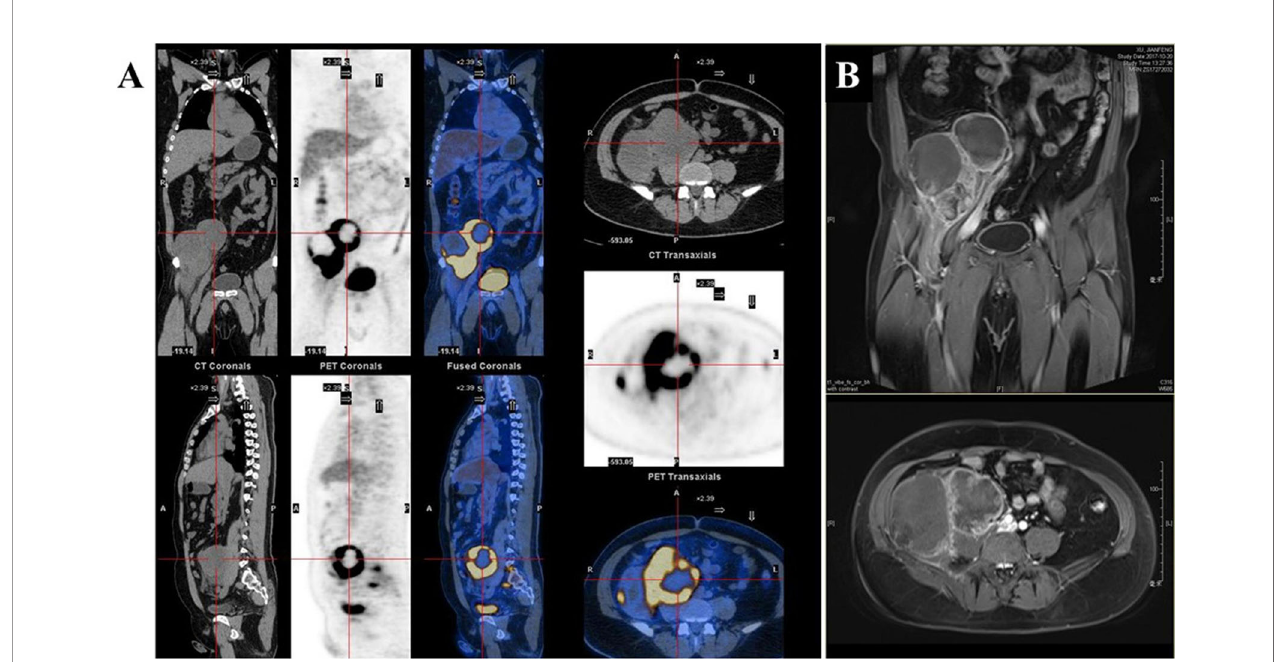
FIGURE 1 | (A) Positron emission tomography/computed tomography (PET/CT). (B) Magnetic resonance imaging (MRI) demonstrated a malignant tumor involving both the right psoas major muscle and anterior iliac